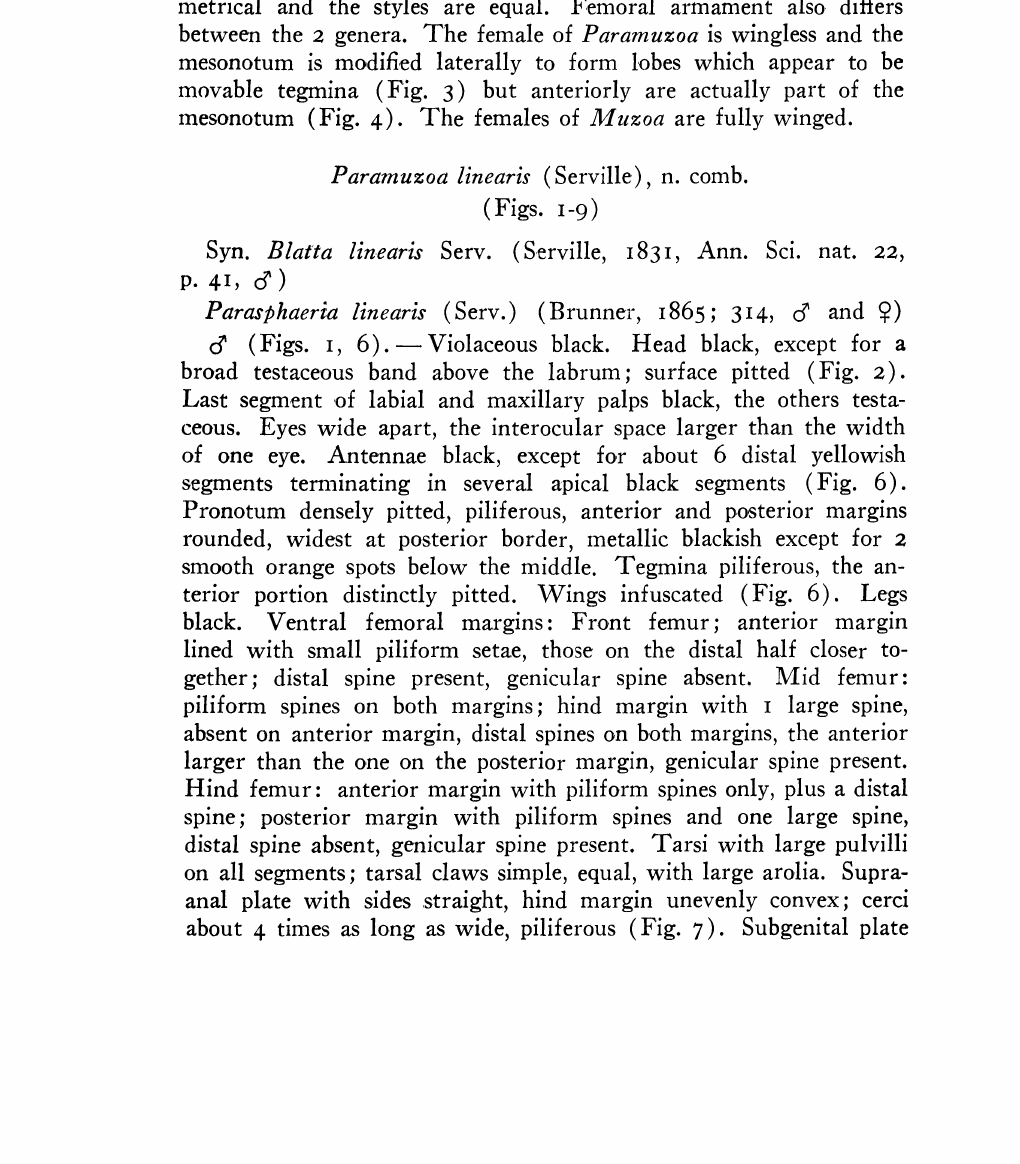
Syn. Blatta lin.earis Serv. (Serville, I83I Ann. Sci. nat. 22, p. 4 I, 0 Paraphaera lineari (Serv.) (Brunner, 865 34, c and )